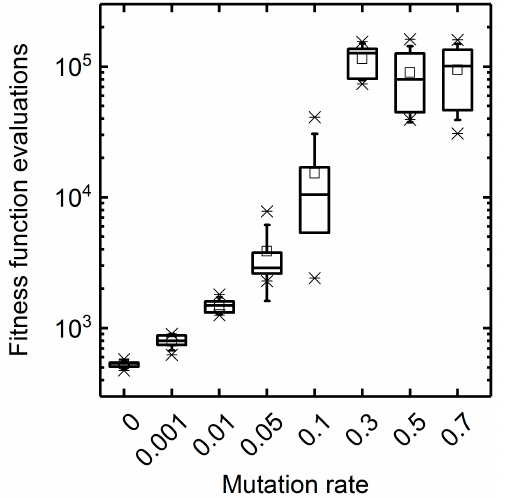
Figure 3. Number of fitness function evaluations until maximal final fitness was reached. Box plots represent five replicate GA runs applying the respective mutation rate. Succinate BPCY was used as the engineering objective.